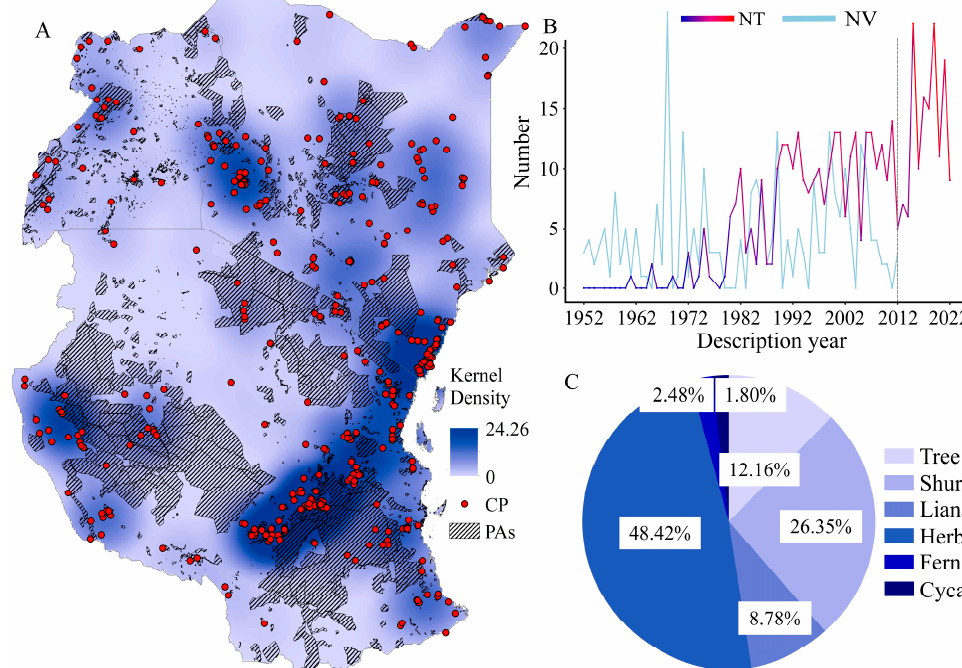
Figure 2. ( A ) Distribution pattern and kernel density of new and newly recorded taxa in tropical East Africa; ( B ) Number of new publication. The blue to red line shows the number of new and newly recorded taxa over the past 61 years (1961–2022) in tropical East Africa, the light blue line shows the number of published volume for the Flora of Tropical East Africa from 1952 to 2012; ( C ) Proportion of the growth habit and life form for the new and newly recorded taxa in tropical East Africa (Protected area data from the World’s protected areas (https://www.protectedplanet.net/en, accessed on 2 November 2022). The dotted line shows the year 2012 when the last volume of the Flora of Tropical East Africa was published. PAs: protected areas; CP: collection point; NT: number of new taxa; NV: number of published volume.